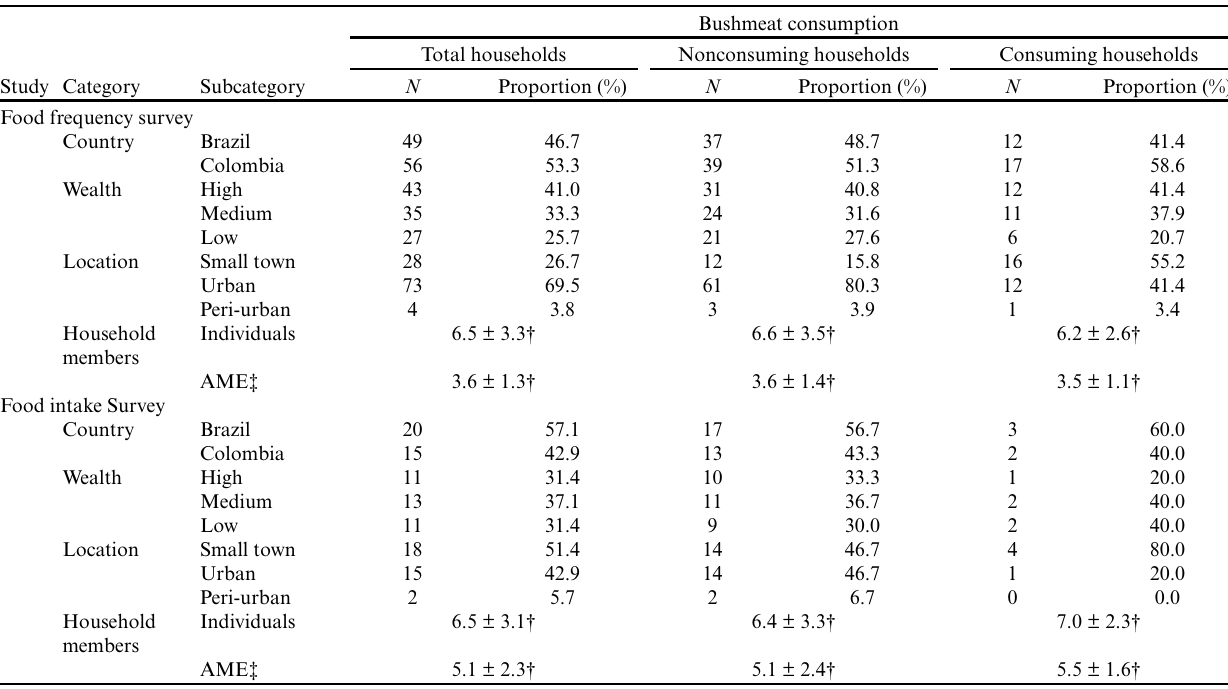
Table 1. Household sample characteristics in food intake and food frequency